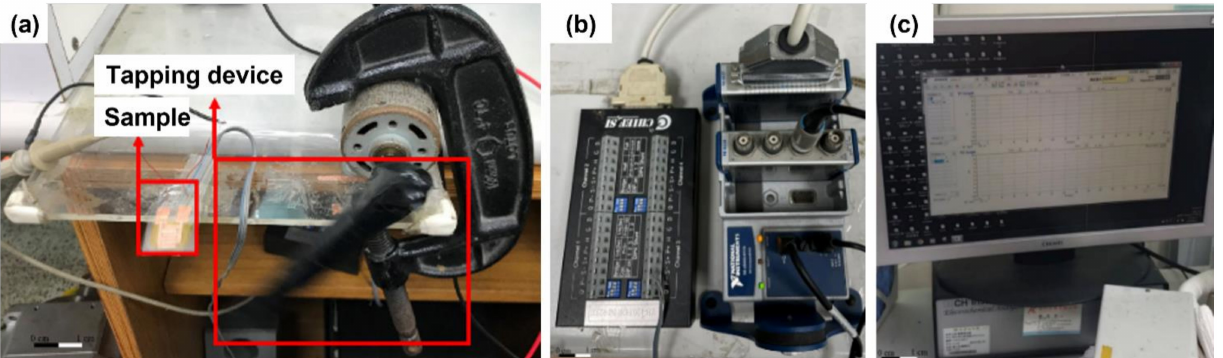
Figure 4. Electrical measurement equipment: ( a ) actual tapping condition, ( b ) strain/bridge input module connected to USB data acquisition device, and ( c ) computer reading